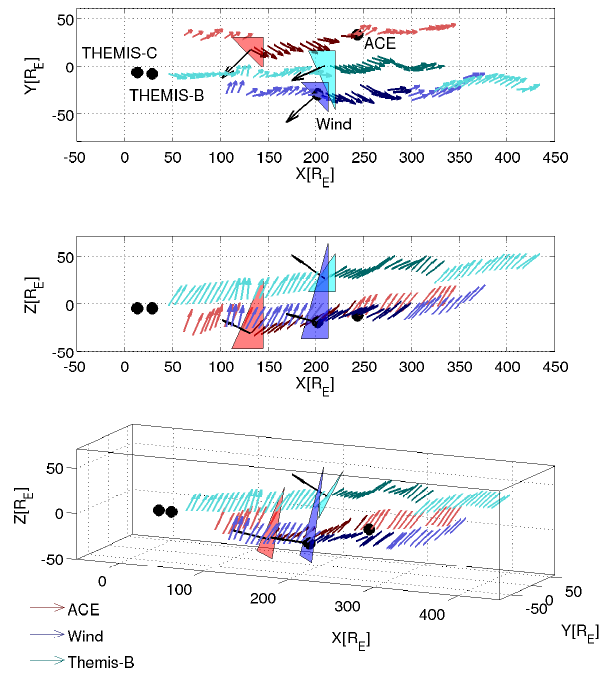
Fig. 6. The top panel: cross-section in the equatorial plane; the second panel: cross-section in the xz-plane; and the last panel: 3- dimensional picture of the IMF by Wind (blue arrows), THEMIS B (cyan arrows), and ACE (red arrows) at the time when Wind ob- served the leading edge of the substructure. The substructure is in- dicated by the darker hue of the arrows. The magnetic field obser- vation was plotted in 3-D space, assuming that the field was frozen in to the flow. The triangular planes depict the leading front of the structure. Black dots denote positions of the